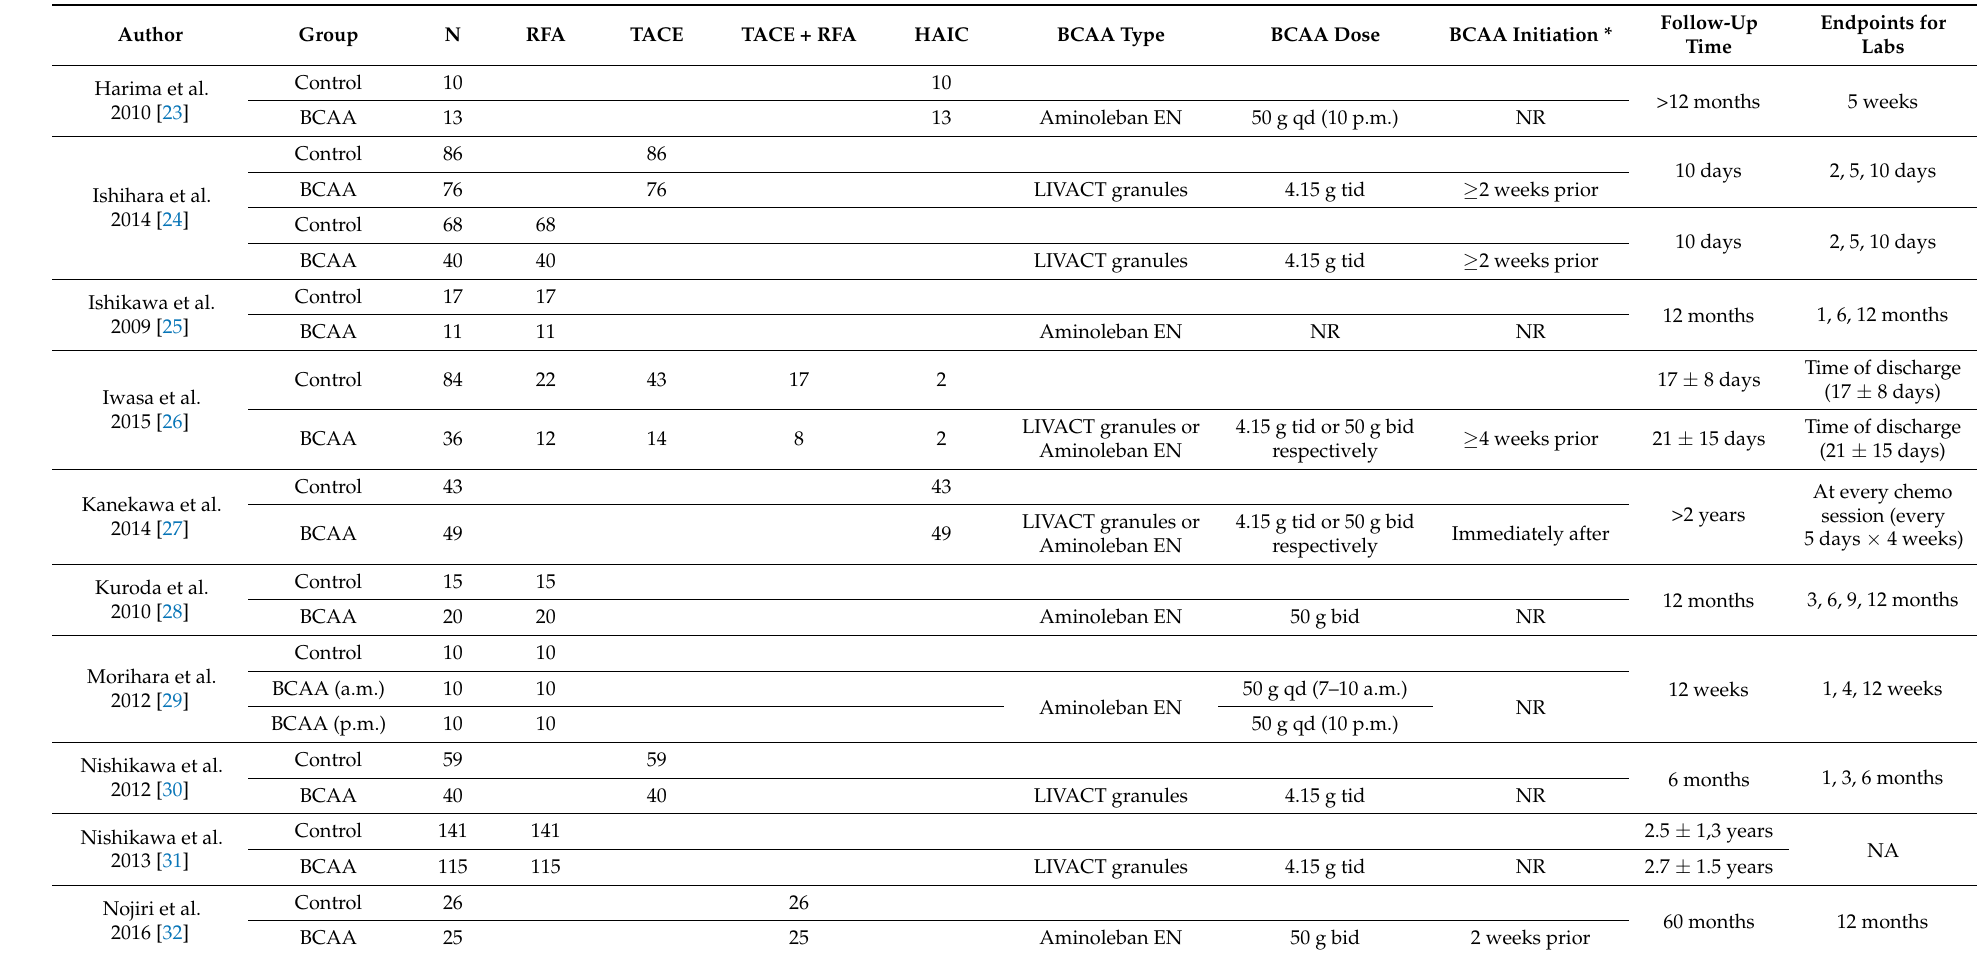
Table 3. Locoregional treatment and BCAA supplementation